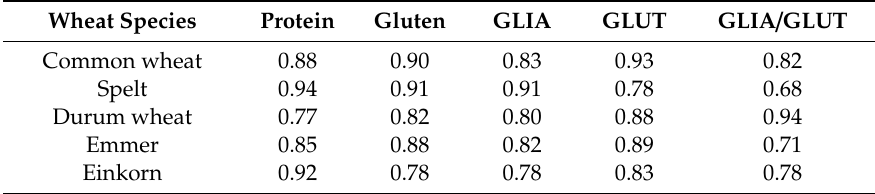
Table 3. Heritability (h 2 ) of the contents of protein, gluten, gliadins (GLIA), and glutenins (GLUT), and the ratio between gliadins and glutenins (GLIA/GLUT), based on 15 cultivars of each wheat species grown at four locations.